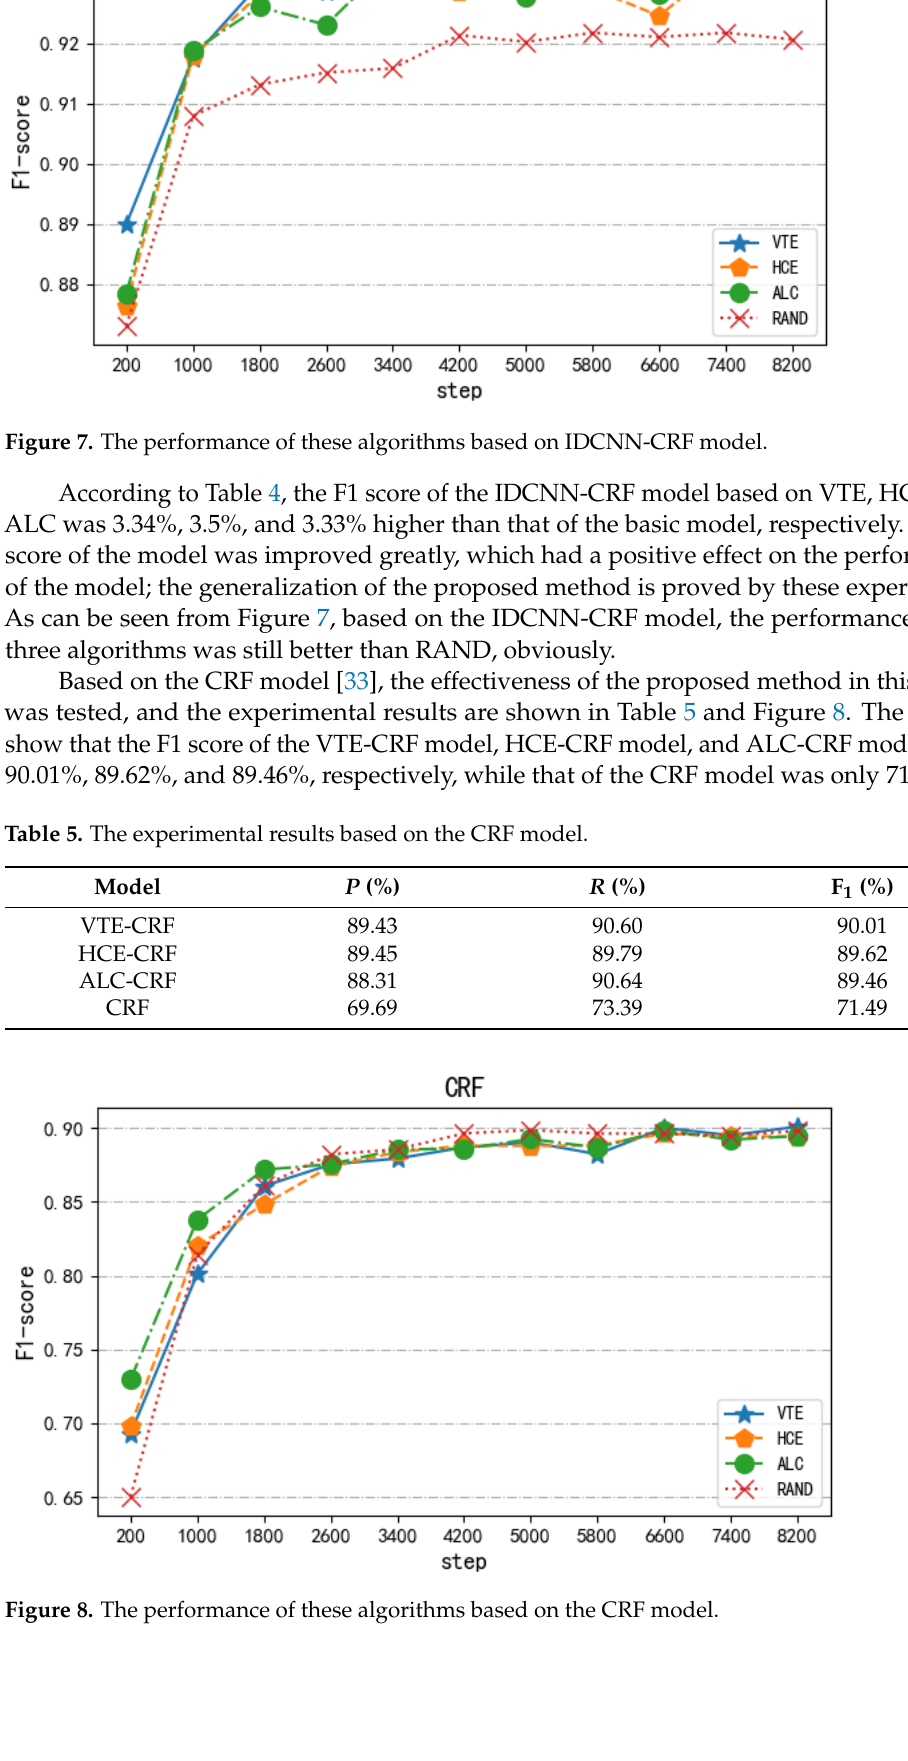
10 of 14 Figure 6. The performance of these algorithms based on the BiLSTM-CRF model. According to Table 3, the F1 score of the BiLSTM-CRF model based on VTE, HCE, and ALC was 94.62%, 94.43%, and 93.64%, respectively, which was higher significantly than that of BiLSTM-CRF model (88.82%); the performance of the model was improved, which proves the effectiveness of the proposed method. It can be seen from Figure 6 that the performance of the three algorithms was obviously better than RAND, which made the F1 score of the model more stable and had a positive effect on active learning training. The highest F1 score (94.62%) was obtained via the VTE-BiLSTM-CRF model, which could better adapt to the text in the field of chemical safety. In situations where samples with different quality are mixed together, through the VTE algorithm, high-quality samples can be effectively screened out, samples with less information can be eliminated, and the iterative efficiency of model training is improved. Compared with RAND, the trend of the F1 score of the HCE-BiLSTM-CRF model was more stable, and the uncertainty of the NER system could be eliminated by the HCE algorithm. In addition, the F1 score of the ALC- BiLSTM-CRF model was 4.82% higher than that of the basic model. The difference be- tween HAZOP samples can be amplified by the ALC algorithm to improve the recognition effect of the model. Based on the IDCNN-CRF model, the reliability and effectiveness of the proposed method in this study was tested, and the experimental results are shown in Table 4. Figure 7 shows the improvement effect of VTE, HCE, ALC, and the algorithm baseline RAND on the performance of this model. Table 4. The experimental results based on the IDCNN-CRF model.